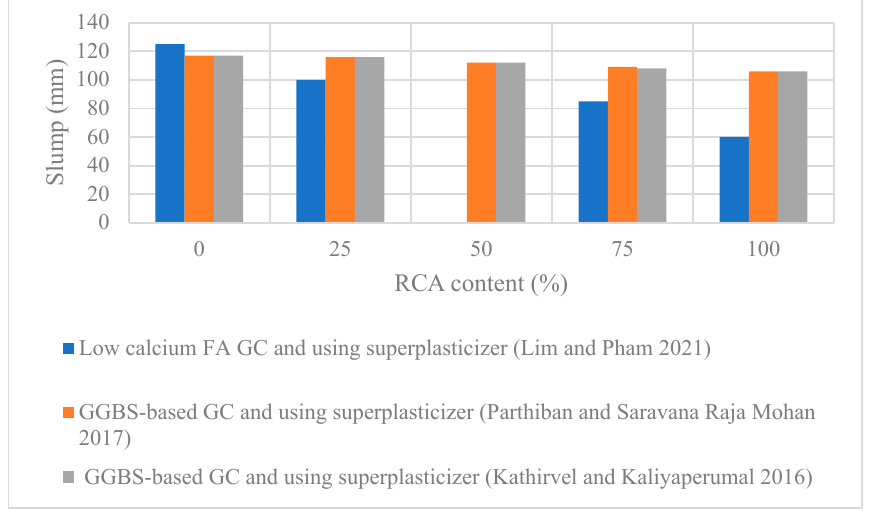
Figure 12. Adverse effect of RCA on workability [17,65,89].